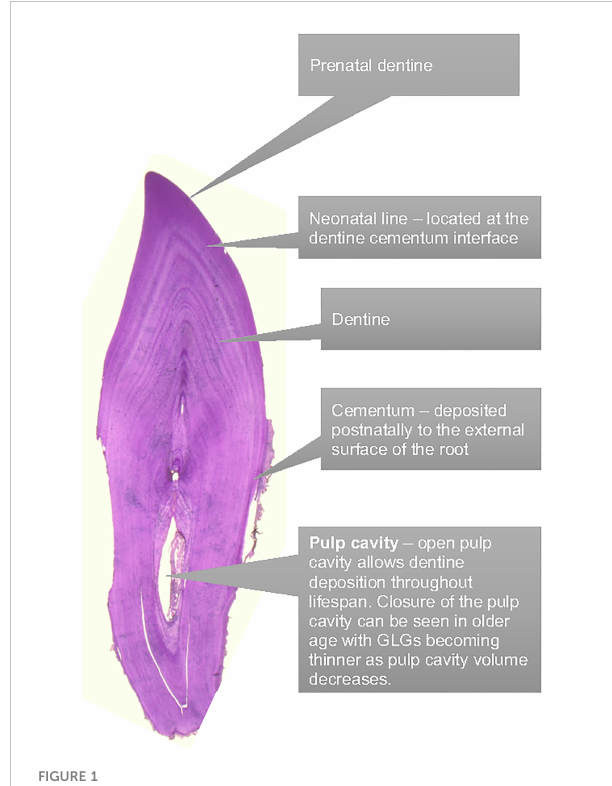
FIGURE 1 Dental anatomy to facilitate the tooth aging via GLG